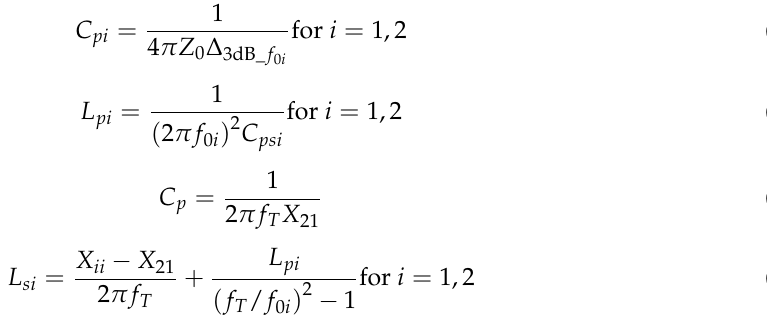
Table 1. The circuit parameters in Figure 5b extracted from the advanced design system (ADS).